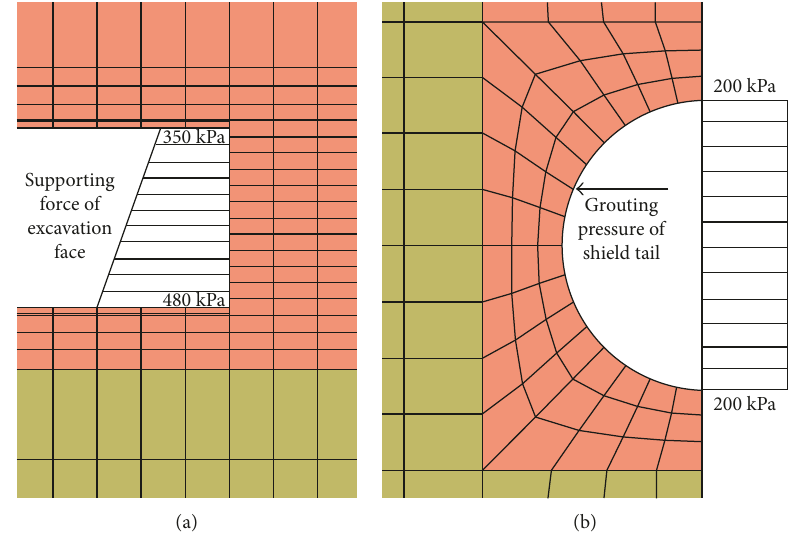
Figure 6: The supporting force by shield machine and grouting pressure at the shield tail. (a) The supporting force at the excavation face. (b) The grouting pressure at the shield